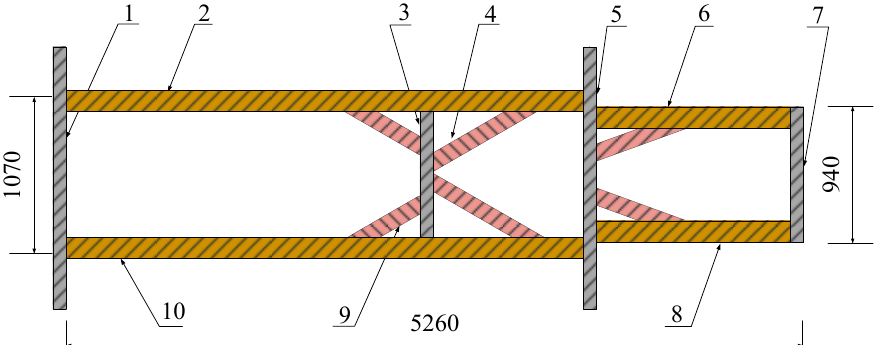
Figure 13. Overall scheme of optimized frame structure.